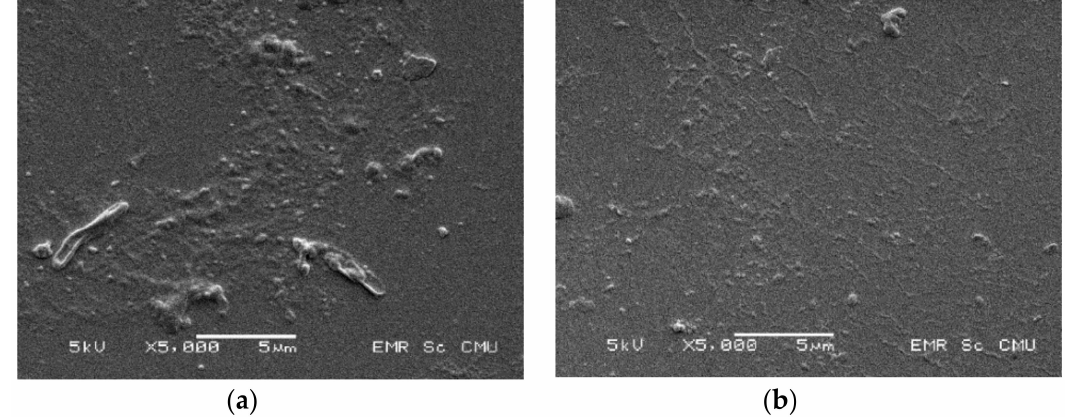
Figure 7. SEM images of GOx coating on Si using ( a ) APTES-GA technique and ( b ) APTES-(EDC/NHS)